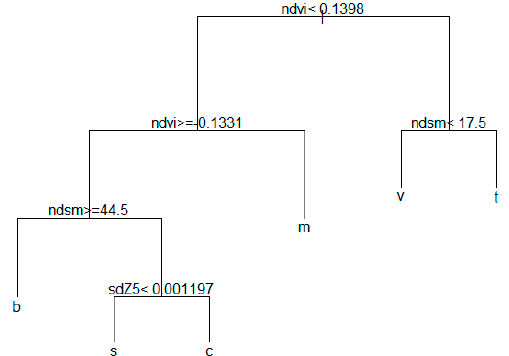
Figure 8. Decision tree derived from an existing land cover map. (b = “building”, s = “impervious surface”, c = “car”, m = “clutter/background”, v = “low vegetation”, t = “tree”; ndvi = normalized difference vegetation index (DN), ndsm = normalized digital surface model (m), sdZ 5 = standard deviation of elevations (Z-values) in the 5 × 5 pixels’ surroundings (m).